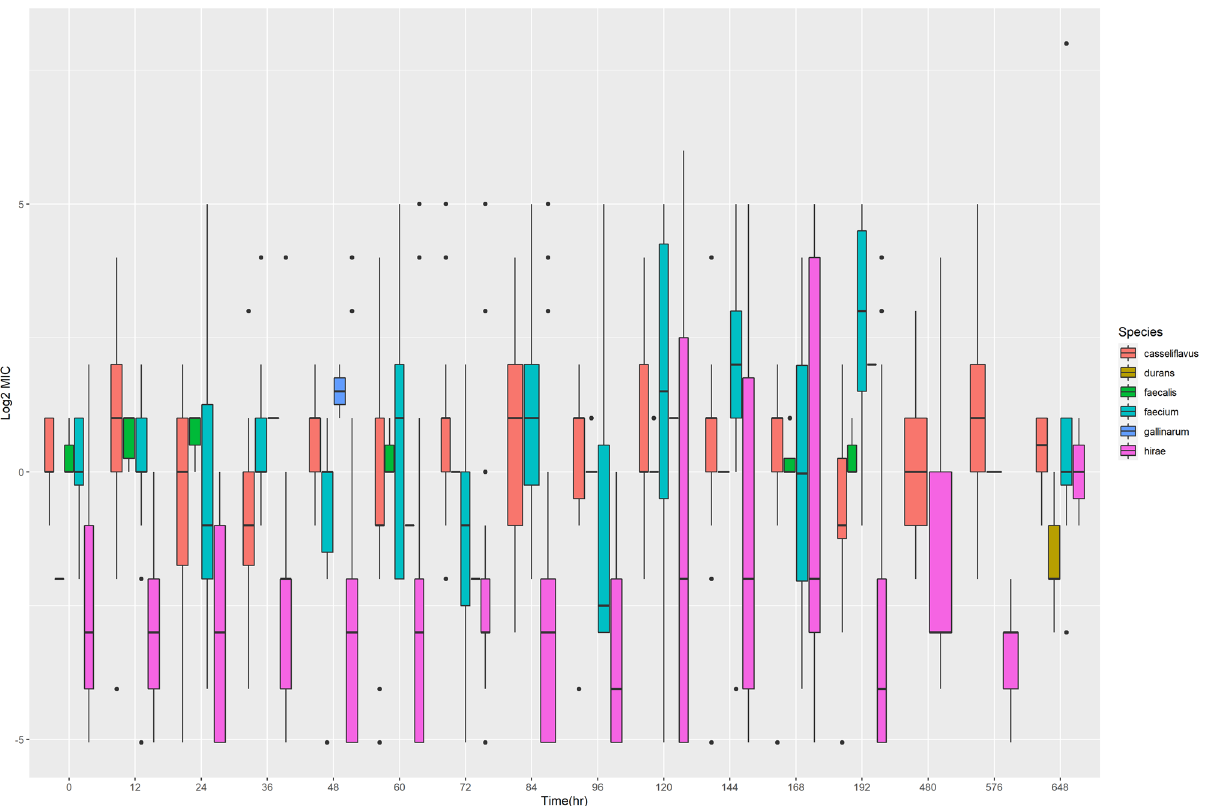
Figure 6. The Log2 MIC value for the identified Enterococcus species over time . The Enterococcus species were determined via MALDI-TOF. The data is presented as a boxplots with the upper and low quartiles present. Outliers are shown as individual black circles. Present species include E. casseliflavus , E. durans , E. faecalis , E. faecium , E. gallinarum , E. hirae